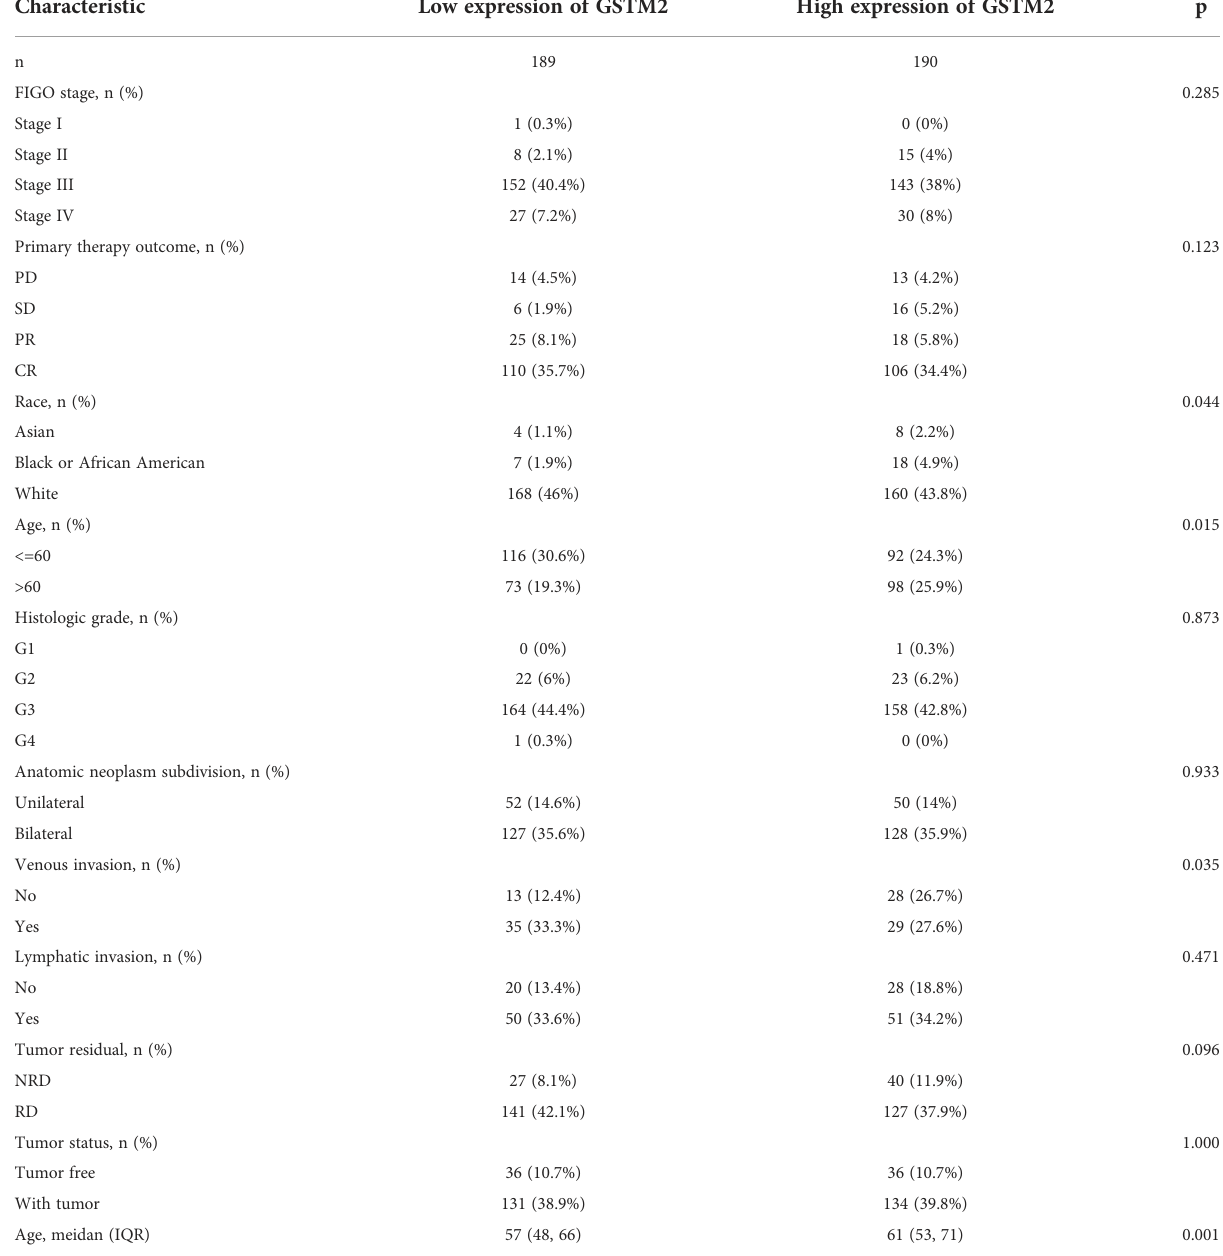
TABLE 2 The correlation between pathological parameters and GSTM2 expression.